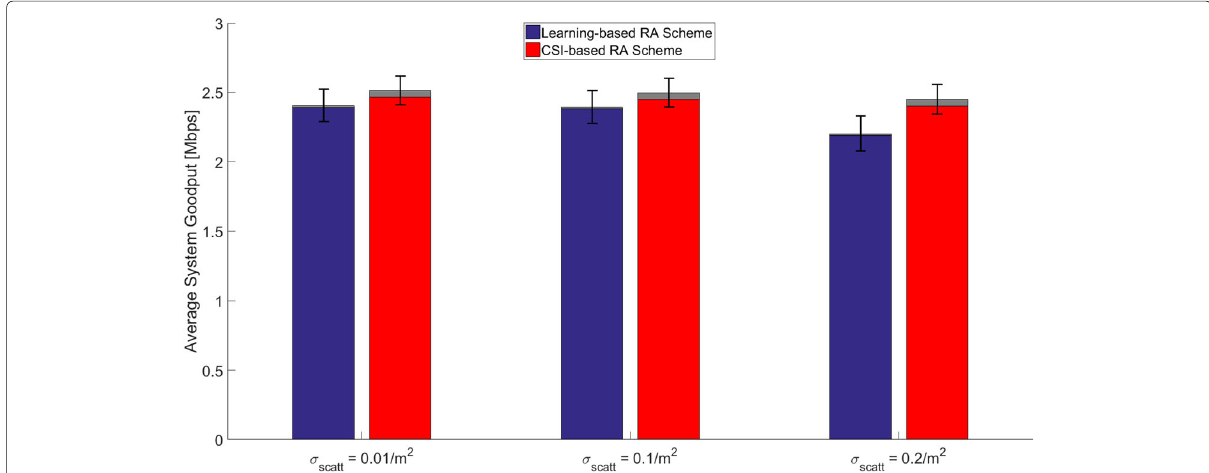
Fig. 7 Average system goodput for different scatterers’ densities for perfect terminals’ position